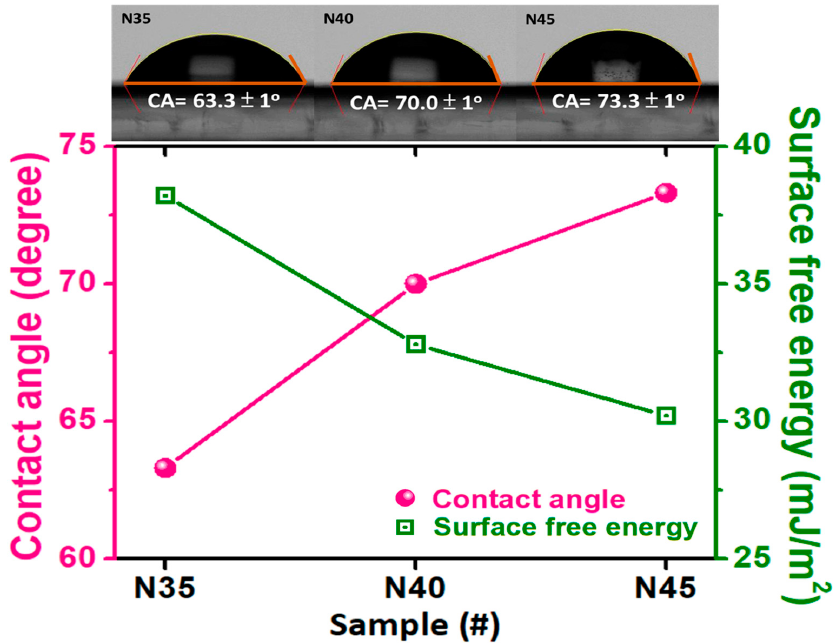
Figure 4. Water-contact-angle (WCA) images and surface free energy for all CrN films with different nitrogen-to-argon